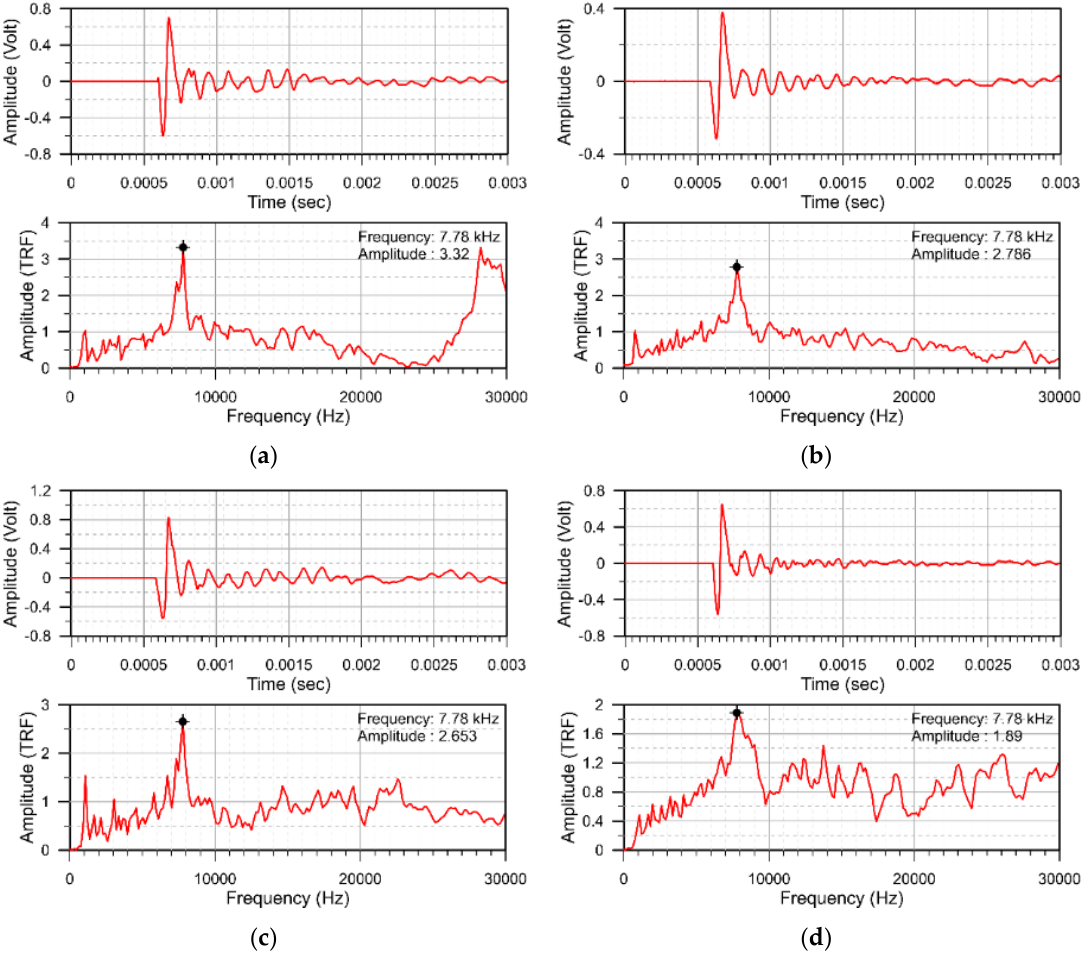
Figure 12. Representative displacement waveform and normalized amplitude spectra for ( a ) good adhesion, ( b ) B10, ( c ) B20, ( d ) B30.